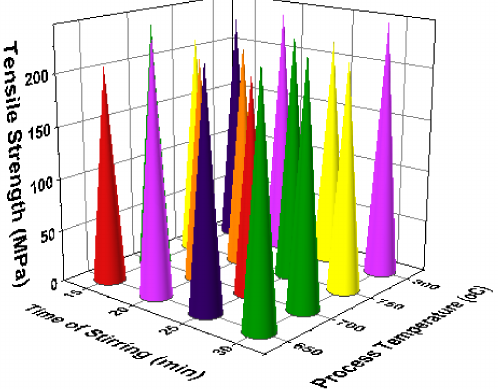
Figure 13. 3D bar plot: time of stirring vs. process